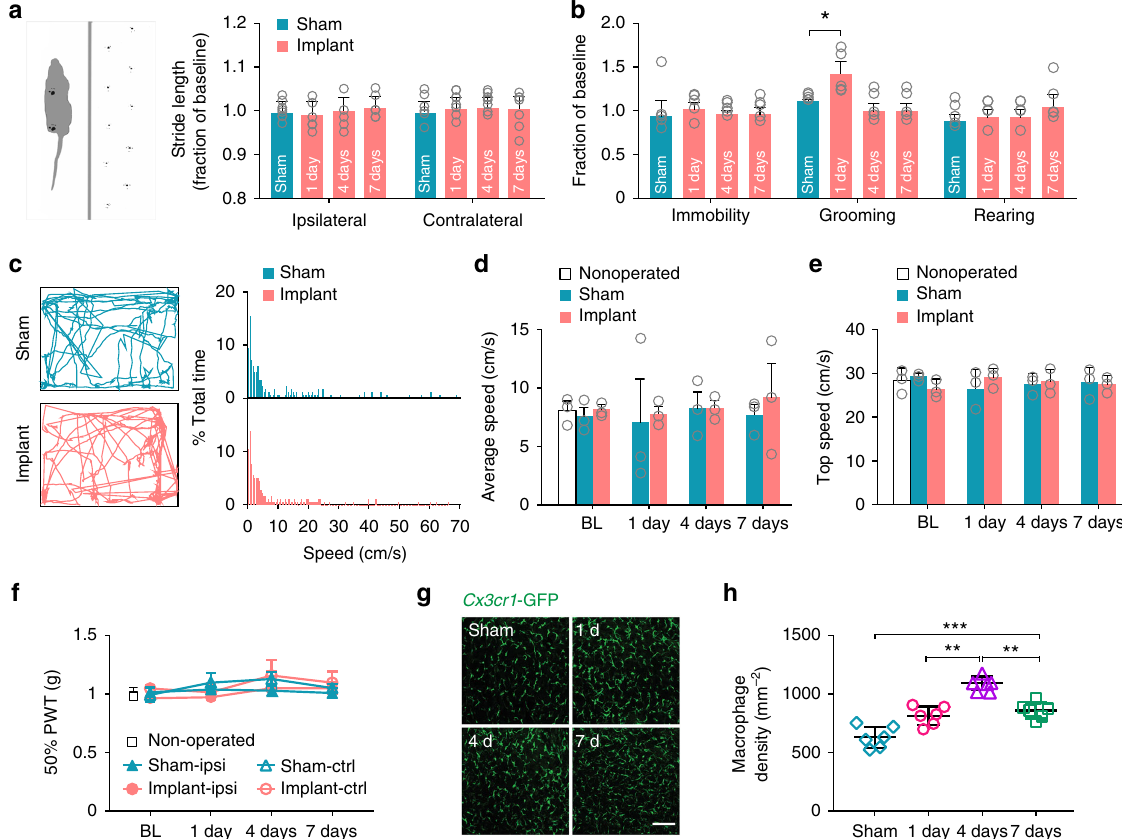
Fig. 2 DRG window implantation has no effects on motor and sensory functions. a Gait analysis. Left: Illustration showing the gait pattern of a mouse running down an enclosed track. Right: Stride lengths of sham-operated mice, and mice with vertebral window implantation. Data were expressed as a fraction of the preoperative within-subject baseline ( n = 8 mice per group). b The cumulative time mice spent rearing, grooming, and immobile during a 5-min open fi eld test. Data were expressed as a fraction of the preoperative within-subject baseline ( n = 5 mice per group). c – e Locomotion behavior. c Left: representative trajectories of an implanted and a sham-operated mouse during a 5-min open fi eld test 4 days after surgery. Right: Speed distribution of implanted and sham-operated mice ( n = 3 mice per group). d and e Average and top speed in the locomotor test. Top speed was calculated from the speed histogram for each mouse as the mean of the speeds above 75 percentile ( n = 3 mice per group). f 50% mechanical paw withdrawal thresholds ( n = 6 mice per group). BL: baseline, measured the day before surgery. ipsi: ipsilateral to the exposed DRG; ctrl: contralateral to the exposed DRG. g Representative images of Cx3cr1 -GFP positive macrophages in L4 DRG. Scale bar, 100 μ m. h Macrophage densities in the DRG of implanted and sham- operated mice ( n = 6 mice per group; 1 day: 814.1 ± 32.7, 4 days: 1092.8 ± 20.7, 7 days: 859.7 ± 28.0, sham: 630.7 ± 37.4; 1 day vs. 4 days, P = 0.002, 7 days vs. 4 days, P = 0.003; 7 days vs. sham, P = 0.0006). Data are presented as means ± s.e.m. * P < 0.05, ** P < 0.01, *** P < 0.001, (RM) one-way